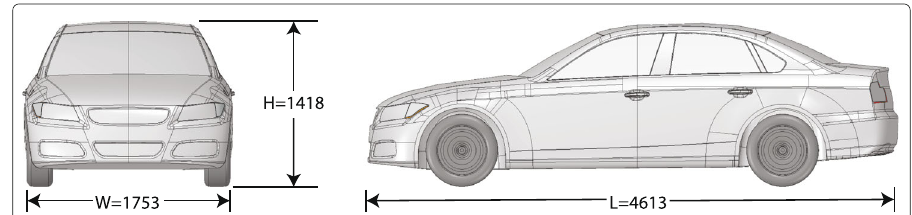
Fig. 1 Notchback DrivAer model with simplified underbody, closed wheels, and no mirrors (dimensions in